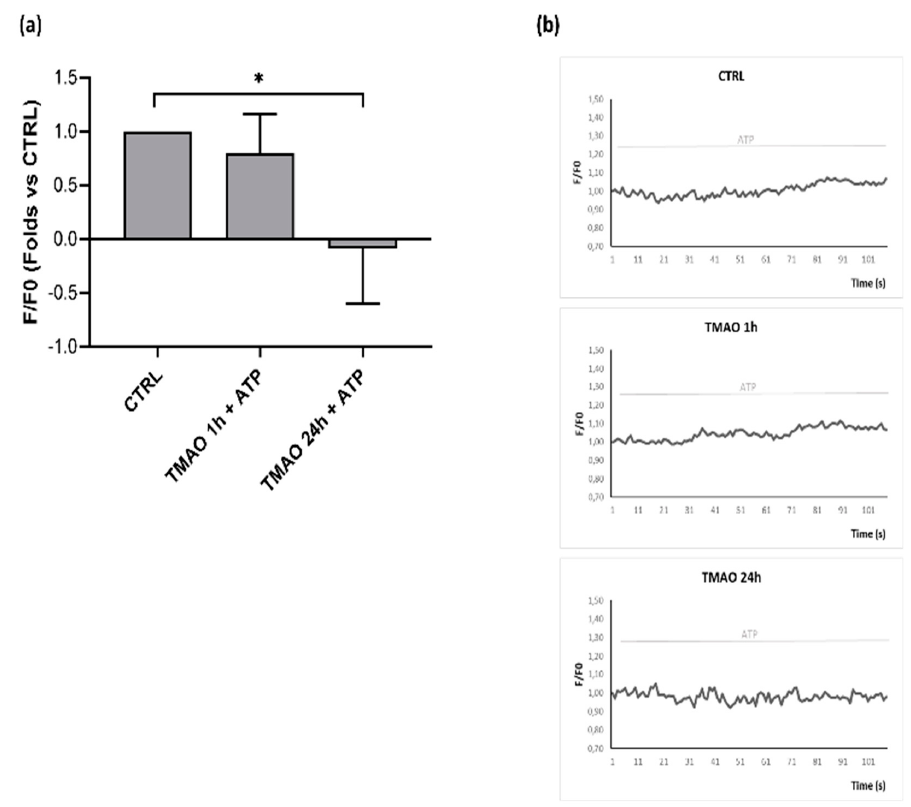
Figure 5. TMAO influences nitric oxide (NO) release in purinergic response to ATP. ( a ) Bar graph showing fluorescence variations before and after ATP stimulation related to basal treatment (CTRL). Treatment with TMAO for 24 h reduced NO release during purinergic stimulation. Number of cells for each experimental condition: CTRL: 63; TMAO 1 h + ATP: 63; TMAO 24 h + ATP: 57 (n = 4 independent experiments). Statistical differences were evaluated with ANOVA and Kruskal–Wallis test. * p < 0.05. ( b ) Normalized traces of fluorescence variations (568 nm) of single cells stimulated with ATP in basal condition and after 1 h or 24 h of TMAO